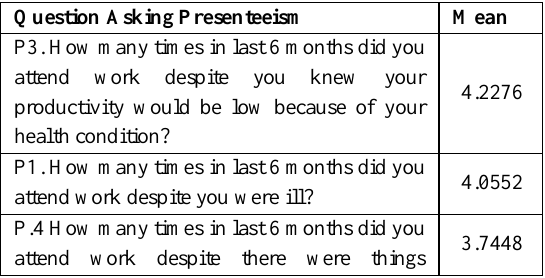
Table 5: Questions Asking Presenteeism and Their Means Question Asking Presenteeism